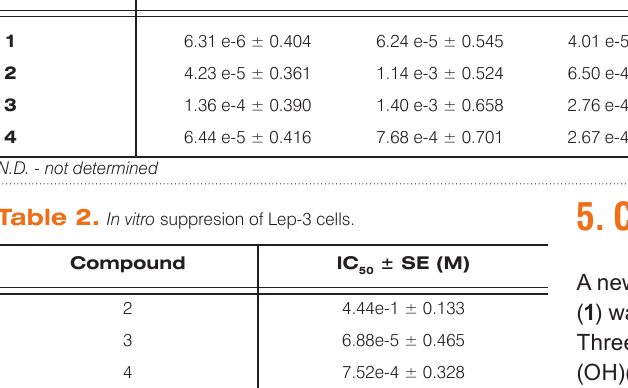
Table 1. In vitro proliferative effects of 1 - 4 towards MDA-MB-231, HT-29, HeLa, HepG2 and Lep-3 cells. Compound